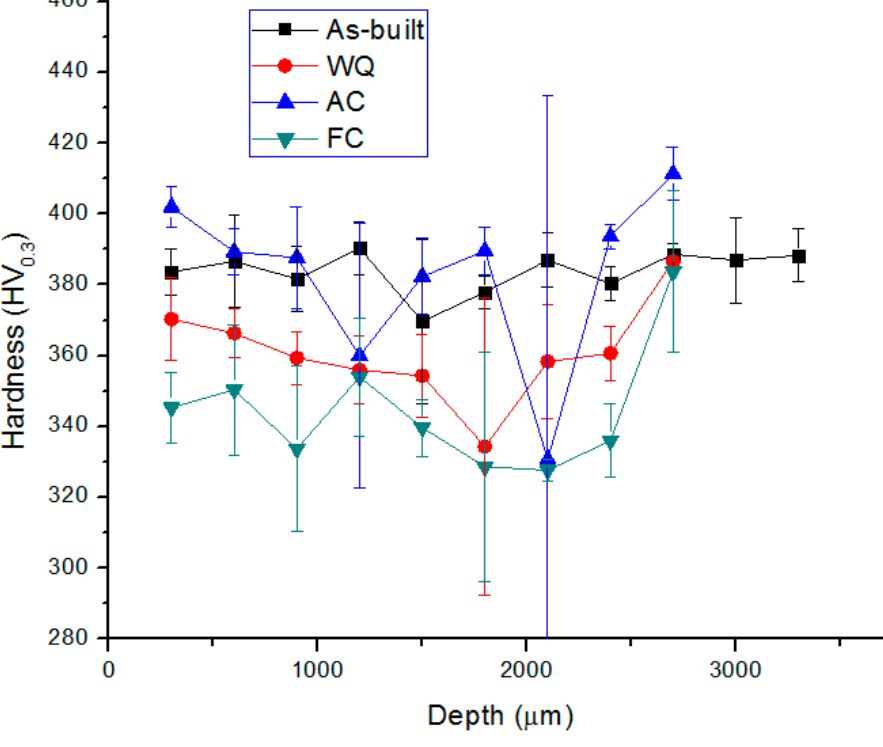
Figure 7. Hardness profiles of the as-built and heat-treated samples. Table 2. Average hardness of the as-built and heat-treated samples. Samples